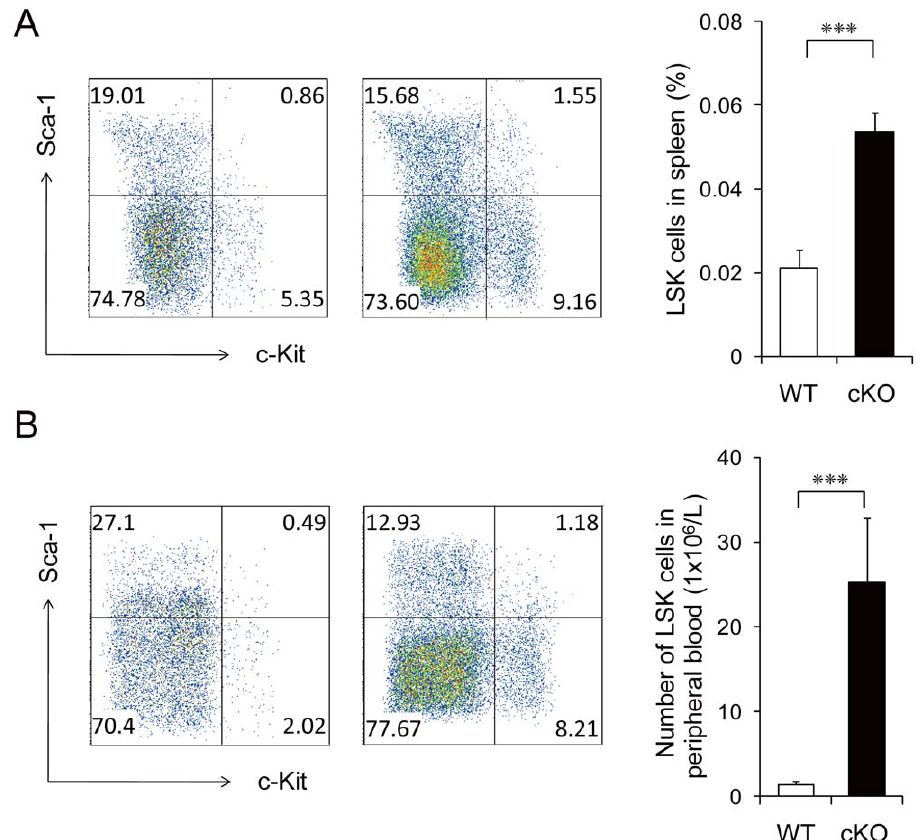
Figure 6. Increased mobilization of Grp94 KO HSCs. A) Representative flow cytometric analysis of splenocytes from WT (n=9) and cKO (n=9) mice using Lin, c-Kit and Sca-1 (left) and quantitation (right). In these studies, splenocytes were extracted from WT and cKO mice 5 days after 7 injections of pI.pC (to examine HSC mobilization before the spleen was enlarged). B) Representative flow cytometric analysis of blood MNCs from WT (n=11) and cKO (n=10) mice using Lin, c-Kit and Sca-1 (left) and quantitation (right). All data are presented as mean 6 s.e., ***p ,